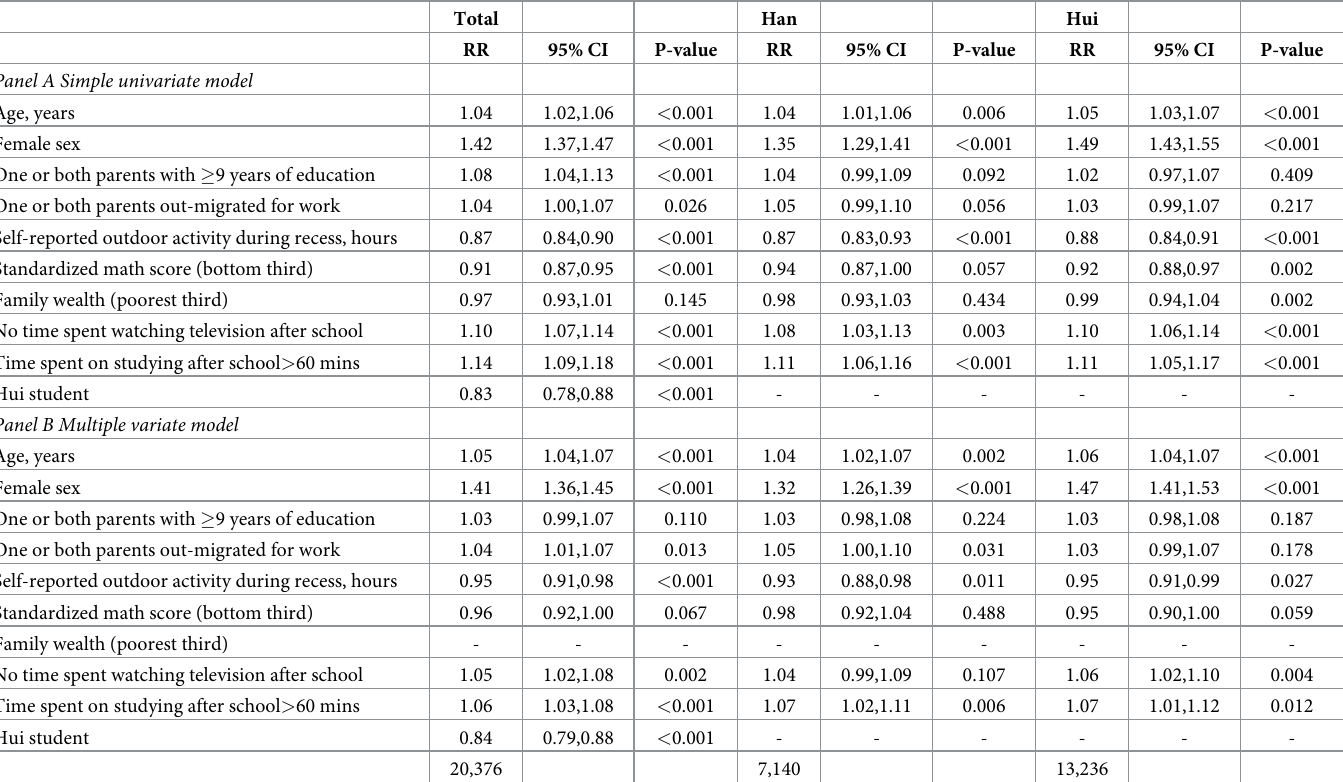
Table 2. Potential risk factors for visual impairment (uncorrected visual acuity < = 6/12 in either eye).